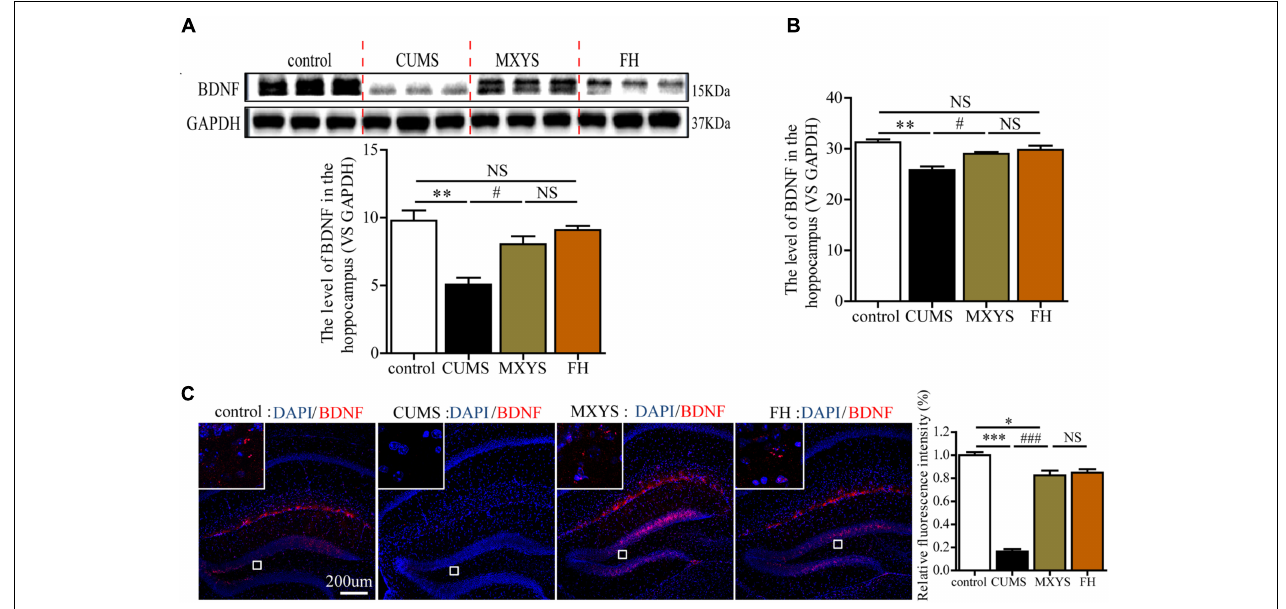
FIGURE 3 | MXYS enhanced the BDNF expression of the hippocampus. BDNF expression in the hippocampus tissue of different groups was detected by western blot (A) and qPCR analysis (B) . (C) Representative micrographs of IF staining for the BDNF proteins (scale bar = 200? µ m, 400 × ?magnification) in the hippocampal DG region. The data are presented as means ± SEM. ∗ P < 0.05, ∗∗ P < 0.01, ∗∗∗ P < 0.001 versus control group; # P < 0.05, ### P < 0.001 versus CUMS group; NS, P > 0.05.